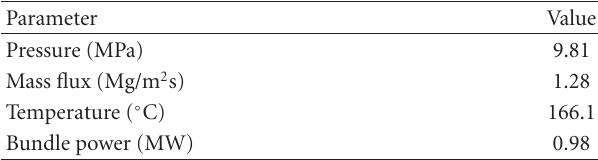
Table 5: Test conditions for case